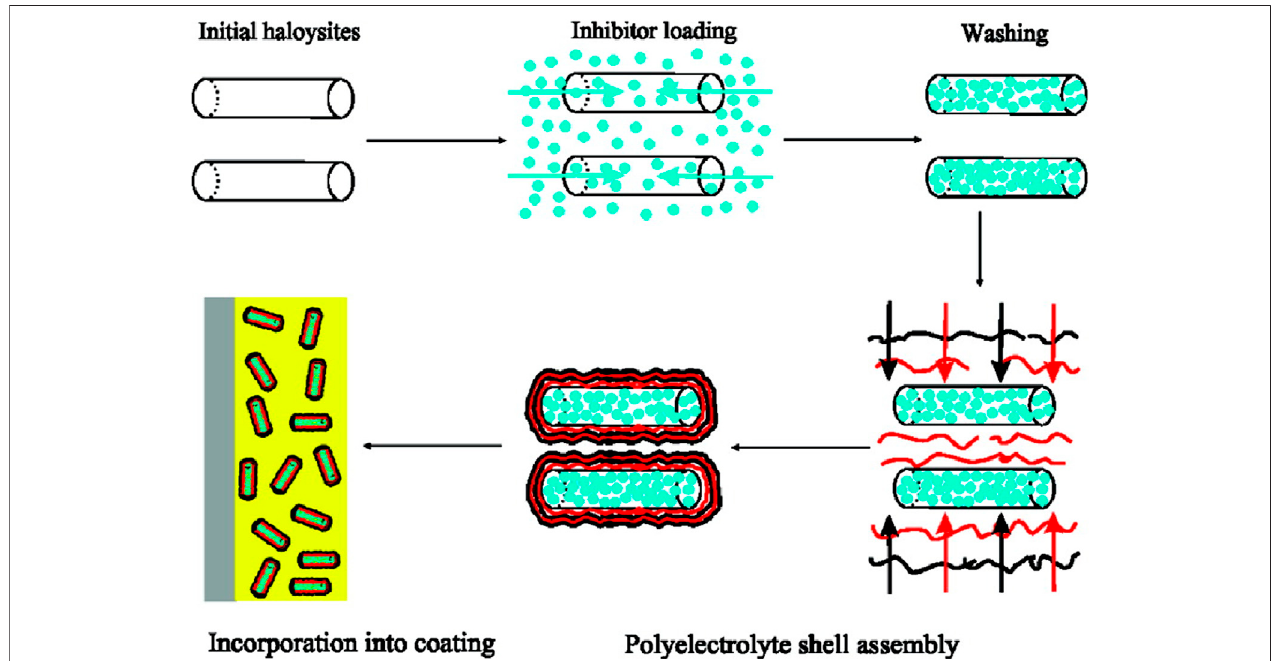
FIGURE 16 | Schematic illustration of the fabrication of 2-mercaptobenzothiazole-loaded halloysite/polyelectrolyte nanocontainers (Shchukin et al., 2008).